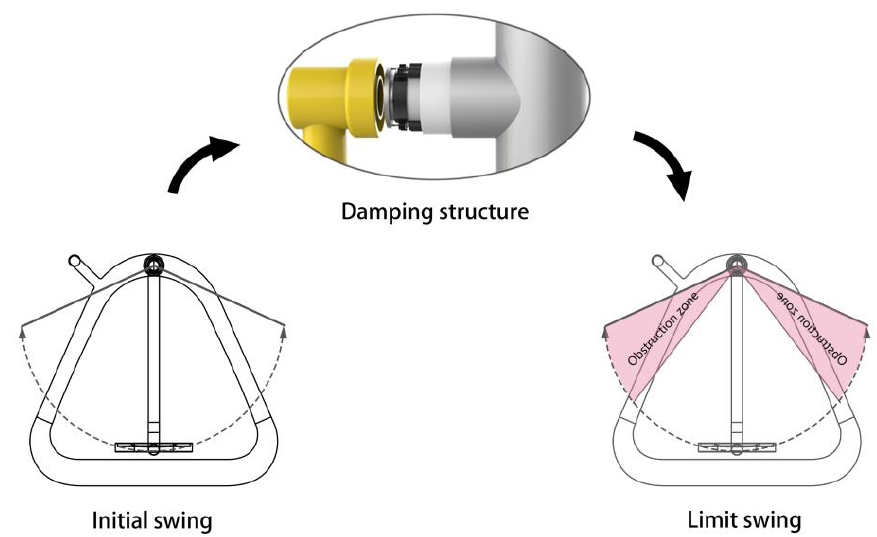
Figure 5. Improved design of stroller safety experience.